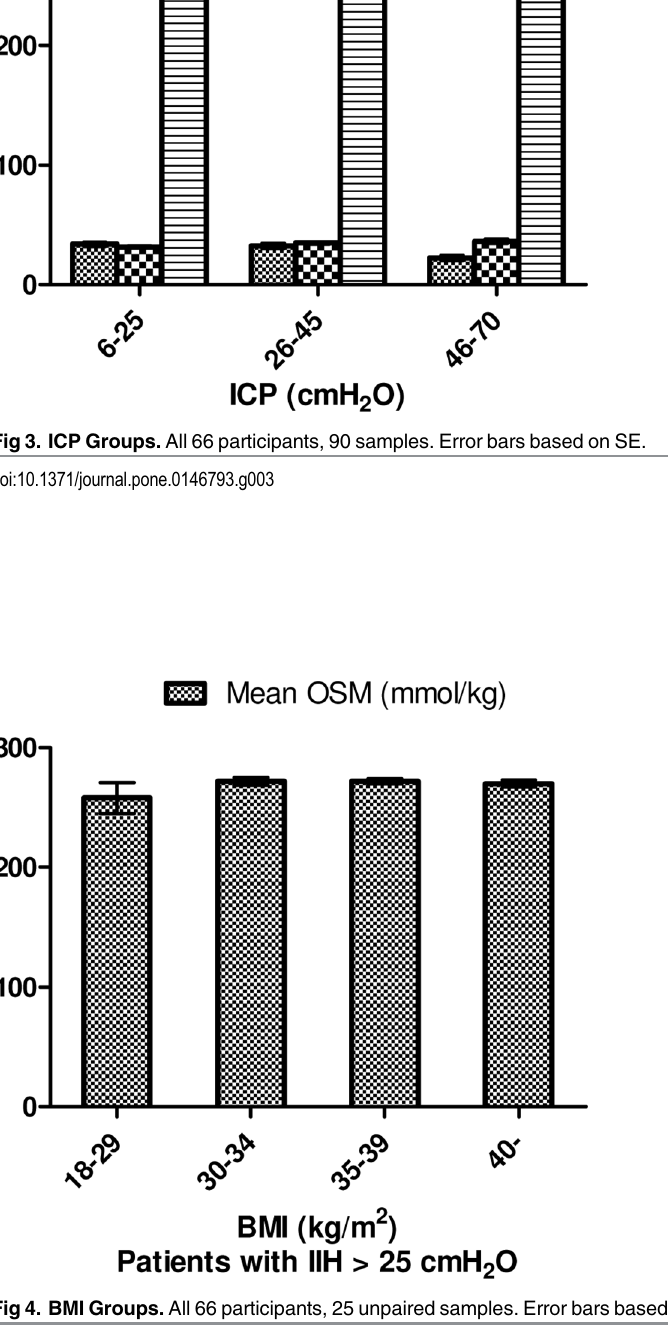
PLOS ONE | DOI:10.1371/journal.pone.0146793 January 25,